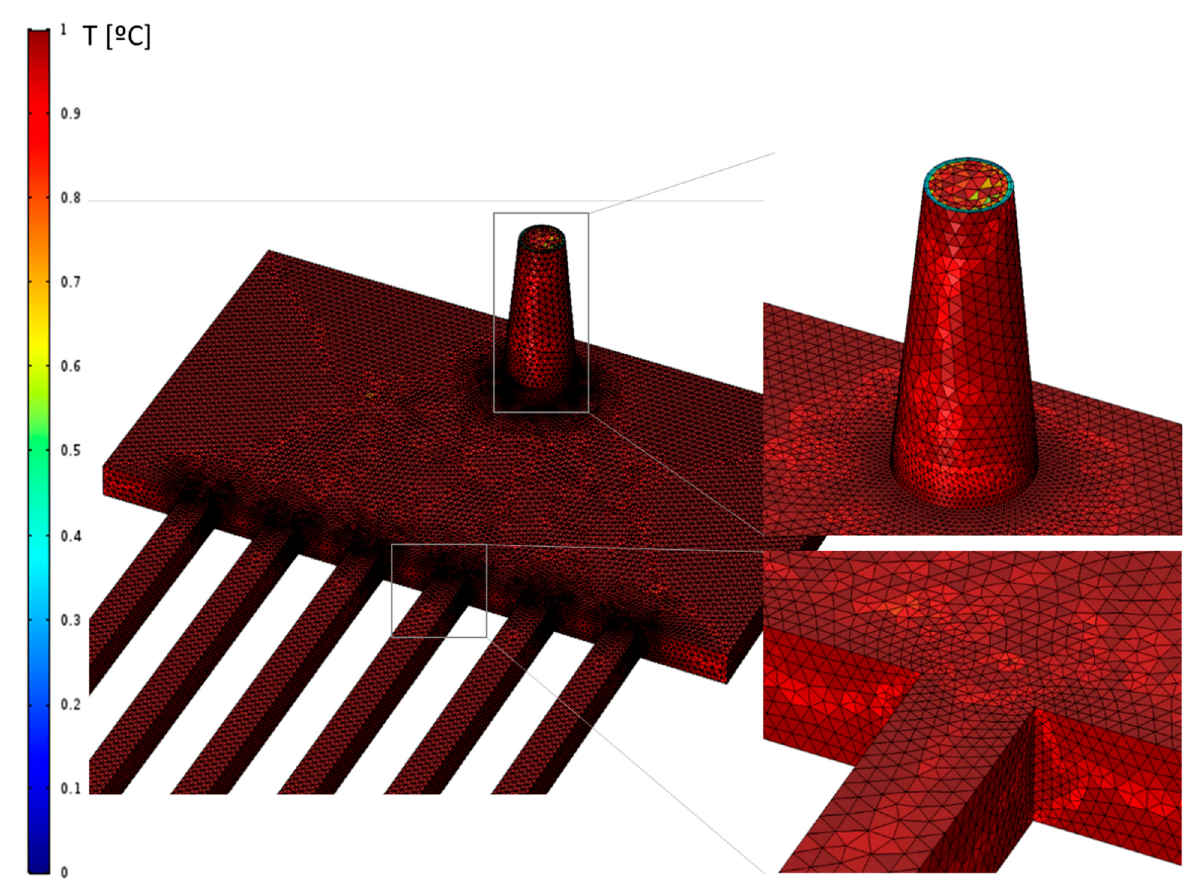
Figure 3. Details of the mesh in the collector.Highlighted: the inlet region and the transition between the collector and the channels.